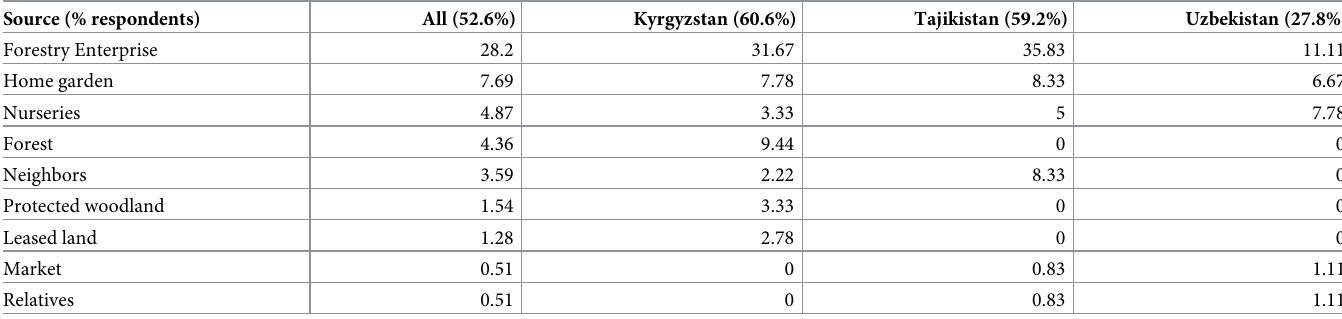
Table 11. Source of reproductive material planted in the